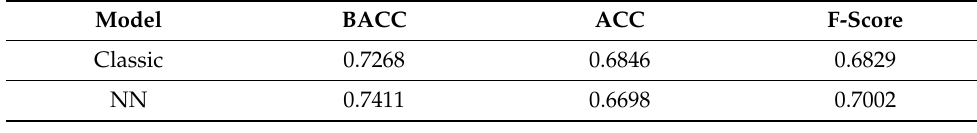
Table 3. Summary of results from our Experiment I.